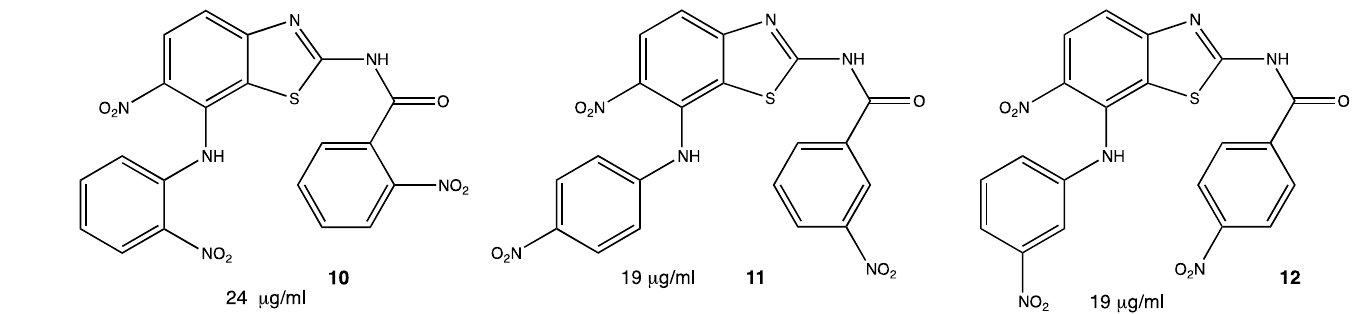
Figure 5. Nitroderivatines containing one F and/or two Cl atoms showed the best activity against S. aureus (15.6–62.5 µ g/mL) and Candida sp. (15–500 62.5 µ g/mL), respectively [27].